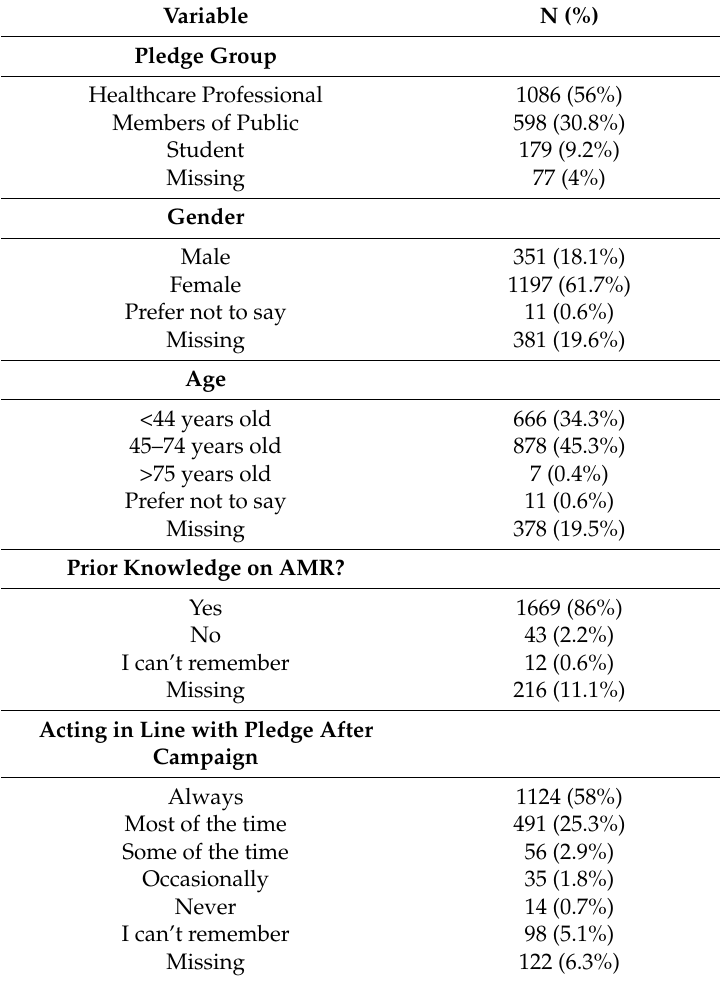
Table 6. Characteristics of respondents, number of observations (N) =